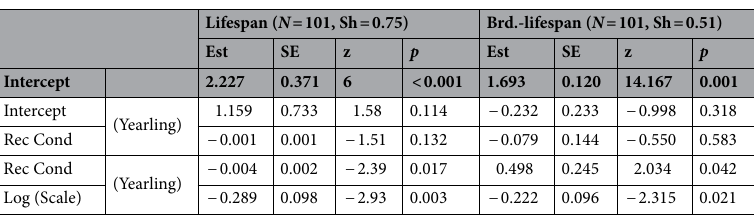
Table 1. Output of best AFT (accelerated failure time) models for peregrine lifespan and breeding lifespan (Brd.-Lifespan). The sample size ( N ) and shape parameter (Sh.) of the Weibull function are indicated for each model, as well as the parameter estimate (Est), its standard error (SE), z statistic, and p for each covariate. Rec Cond stands for conditions experienced upon recruitment. With (Yearling), the corrections for the intercept and trends estimated for that group are